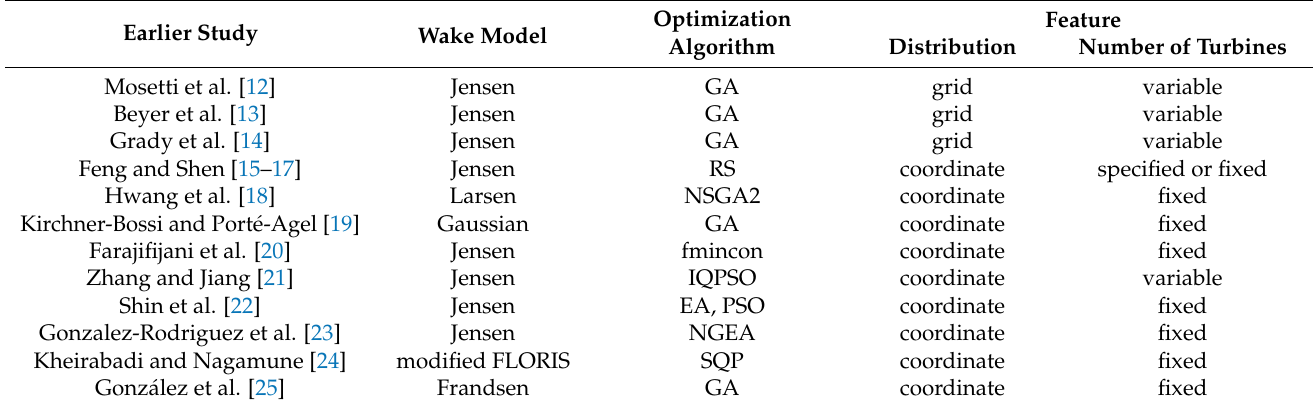
Table 1. Summary of earlier